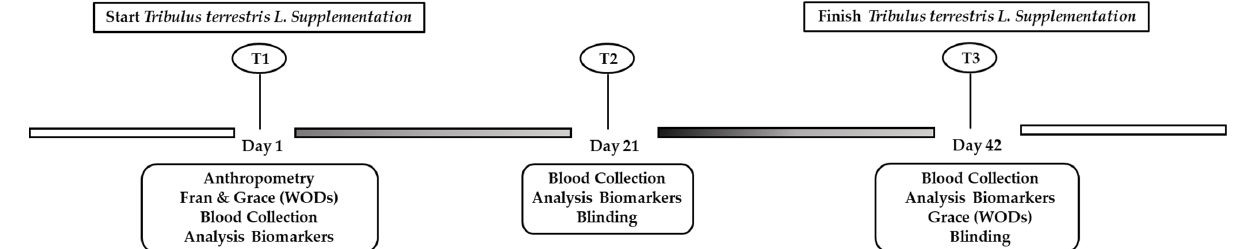
Figure 1. The implementation schedule for the 6 weeks of the